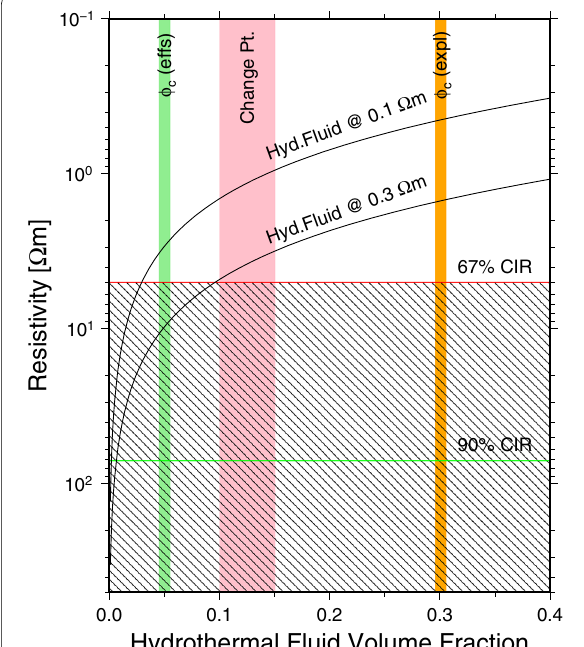
Fig. 21 Bulk resistivity of two phases (hydrothermal fluid–rock) as a function of the hydrothermal fluid volume fraction (solid line). Hydrothermal fluid resistivity is assumed to be 0.1 or 0.3 Ωm. Rock resistivity is fixed at 1000 Ωm (see Fig. 19). The green, orange, and pink columns show percolation threshold porosity in effusive and explosive eruptions, and change point of permeability–porosity relationship, respectively. The red and green lines show the upper bounds of 67% and 90% CIR of the conductor (see Fig. 14b). The oblique pattern represents likely resistivity range at the Mogi inflation source location, assuming that the upper bound of CIR of the conductor restricts the lower bound of resistivity at the Mogi